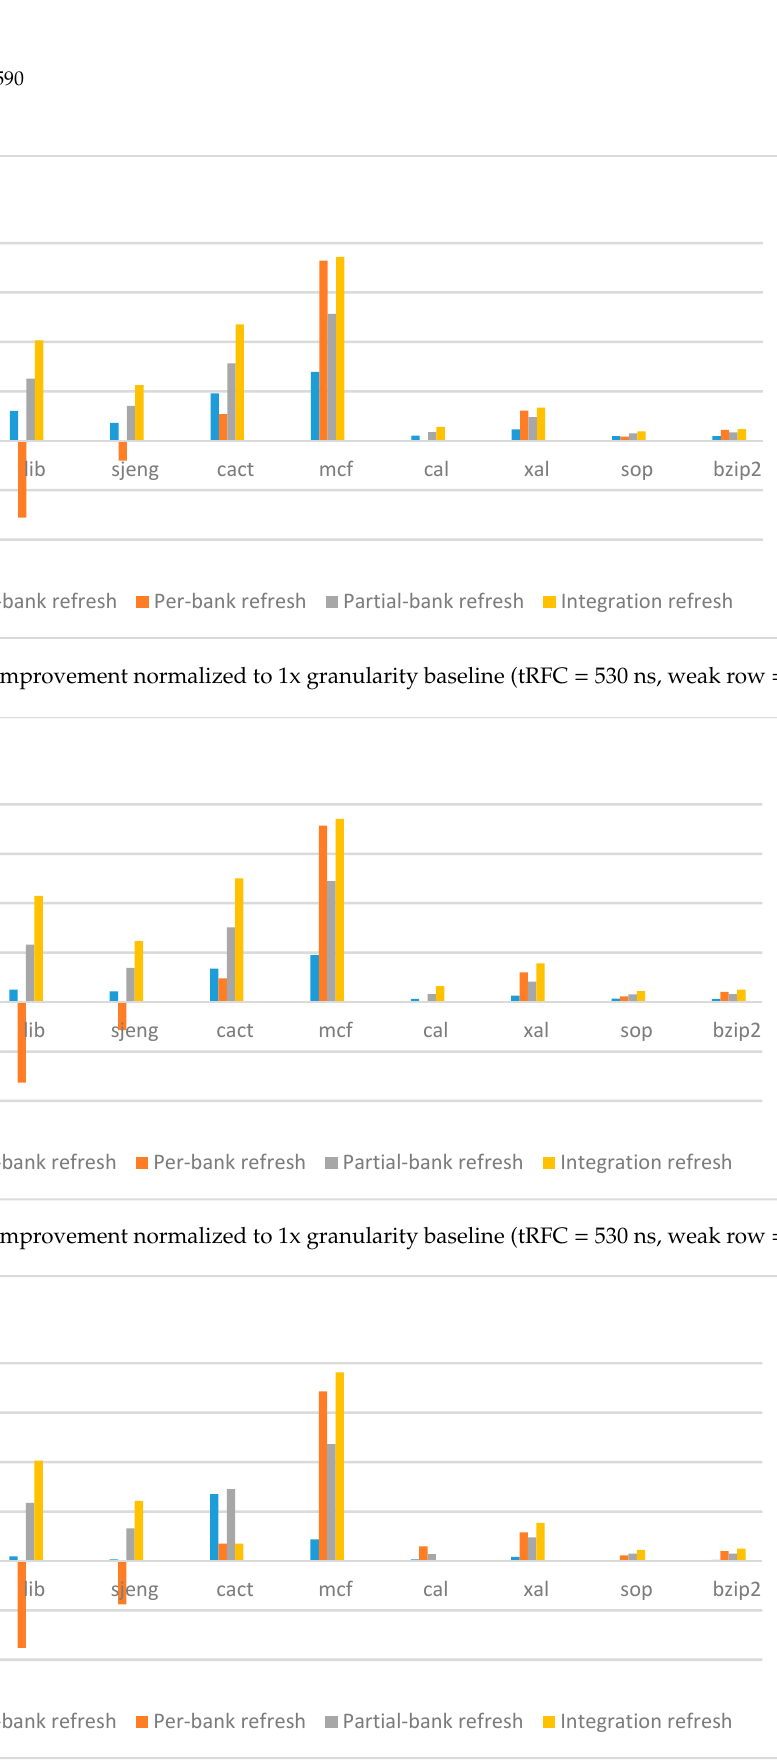
Figure 17. IPC improvement normalized to 1x granularity baseline (tRFC = 530 ns, weak row = 5%).